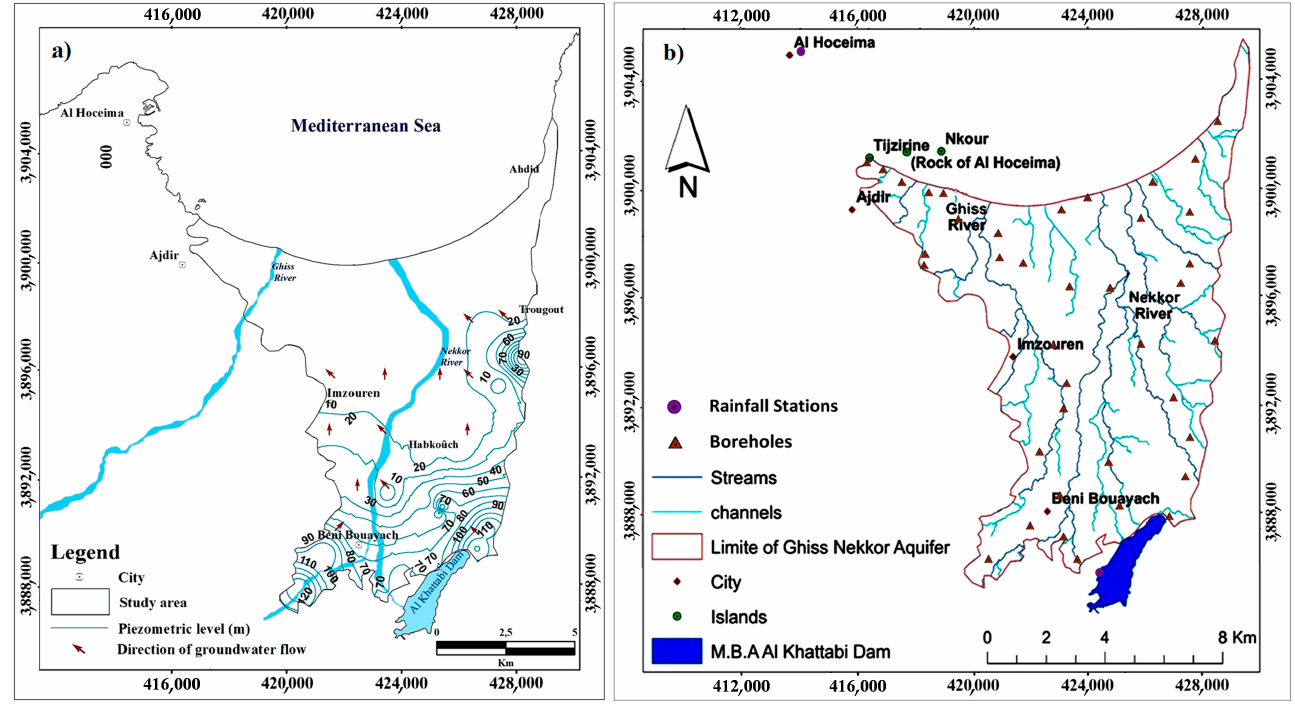
Figure 2. ( a ) Piezometric map and ( b ) hydrographic network of the Ghiss Nekkor